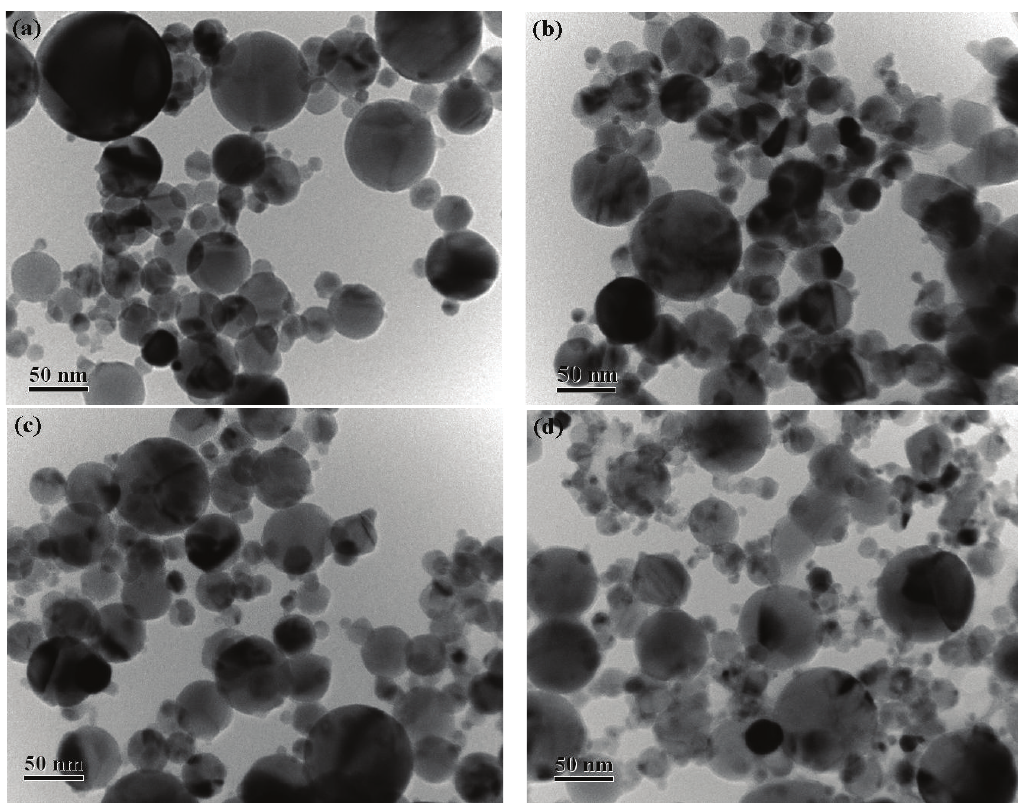
Figure 2: TEM images of TiO 2 nanoparticles synthesized at Al 2 O 3 /Ti mass ratio of (a) 0, (b) 0.1, (c) 0.3, and (d) 0.5.